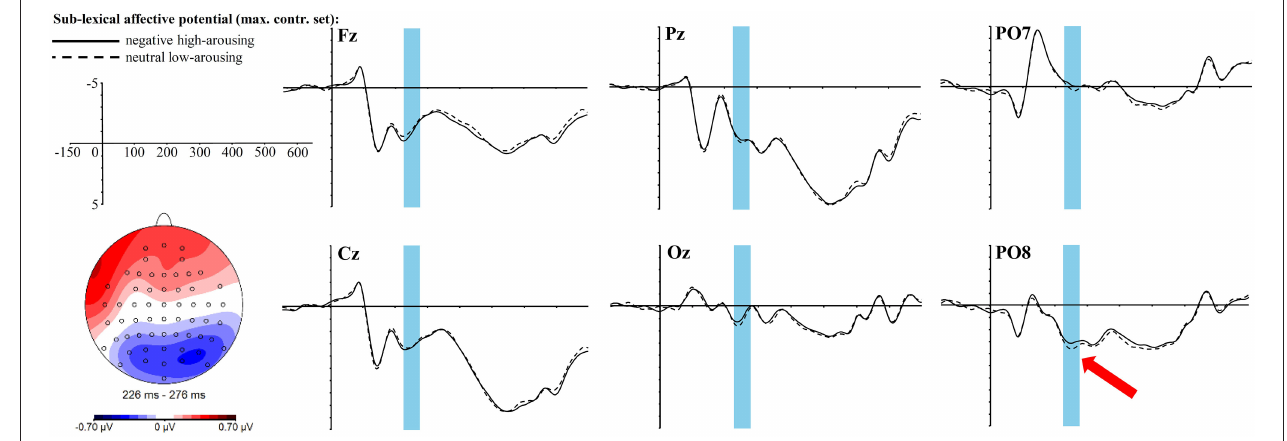
FIGURE 5 | ERP effect of the sublexical affective potential in the maximally controlled stimulus set at selected electrode sites. The red arrow indicates at which electrode the effect is most pronounced. For the topographic map sublexically neutral low-arousing words were subtracted from sublexically negative high-arousing